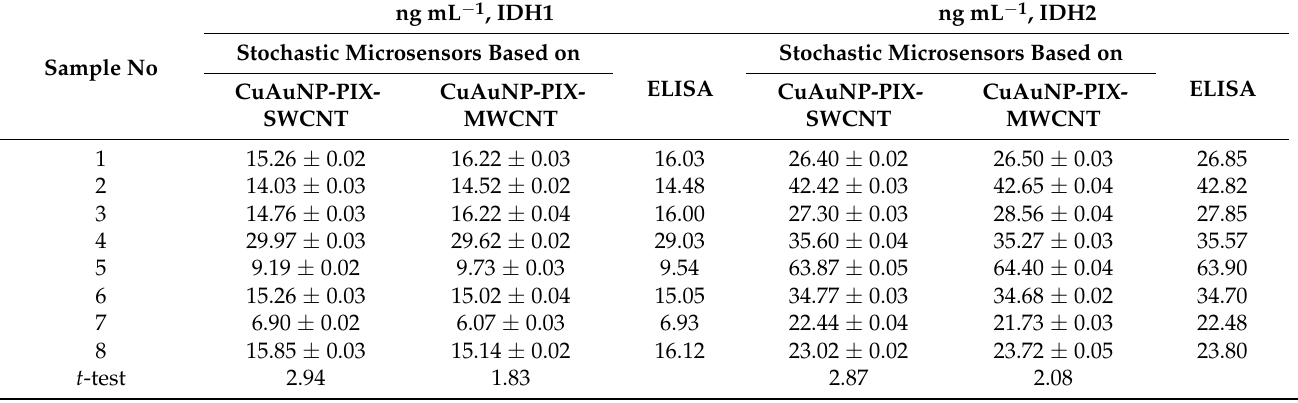
Figure 5. Examples of diagrams recorded for the molecular recognition of IDH1 and IDH2 in whole blood samples using the stochastic microsensors based on ( A ) CuAuNP-PIX-SWCNT and ( B ) CuAuNP-PIX-MWCNT. Table 4. Determination of IDH1 and IDH2 in brain tumor tissue samples using the stochastic microsensor and